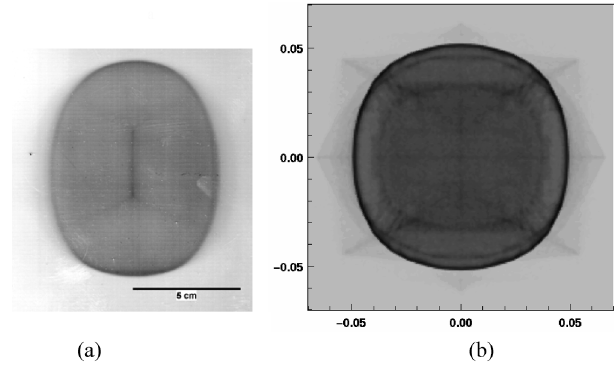
FIG. 13. Images of the beam at the exit of the injector. (a) Kapton film image taken after modifications were completed, (b) corresponding time-integrated image obtained from simula- tion (scales as (cid:5) 1 : 9 to 0 : 9 (cid:8) mm mrad (vertical), re- fication, from " n flecting the improved optics. The red ellipses show the ideal phase-space distribution limit for a uniform beam of equivalent rms size and emittance.